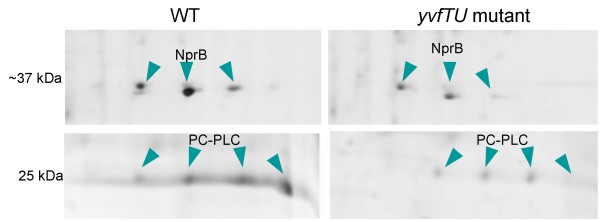
2D-GE of WT and yvfTU mutant culture supernatants collected 2 hours after the onset of stationary phase. Spots found in lower amount in the extracellular proteome of the yvfTU mutant correspond to NprB and PC-PLC proteins, as confirmed by Mass Spectrometry identification. The different spots correspond to isoforms of the same protein, with distinct charges but identical molecular weights. The gel areas shown are located around 37 kDa with a pI between 5.5 and 6 for NprB, and 25 kDa with a pI between 6.0 and 7.0 for PC-PLC.